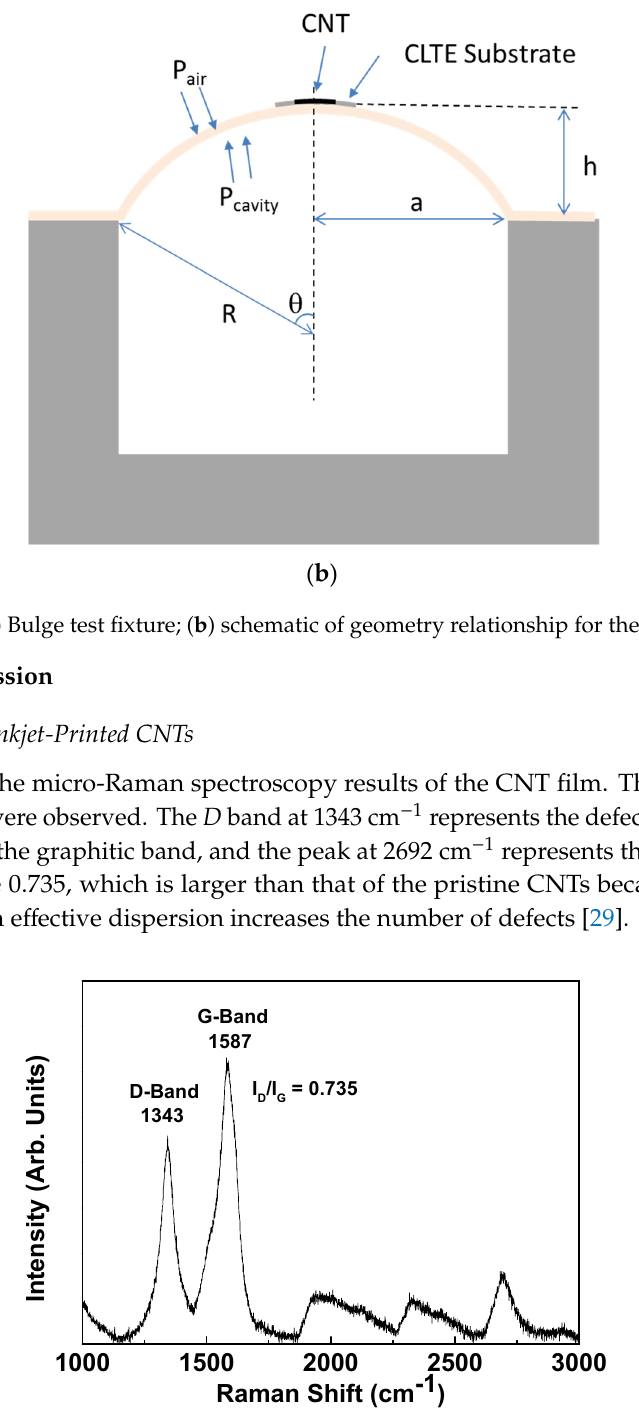
Figure 3. Raman measurements for inkjet-printed CNT film.